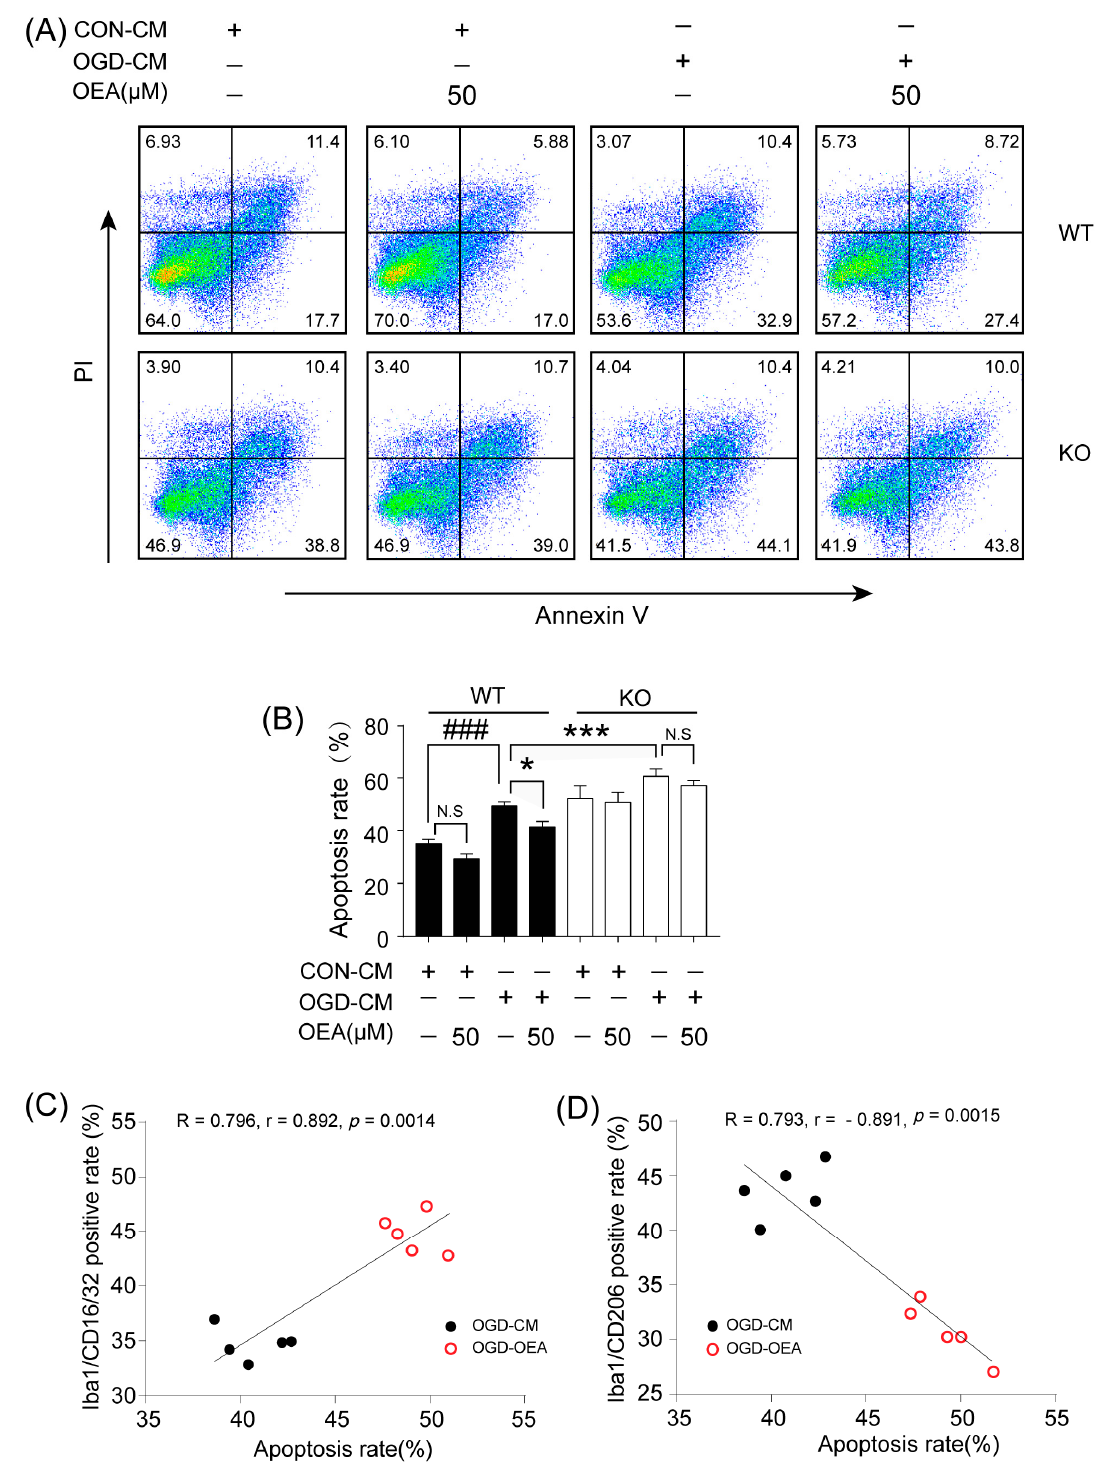
Figure 8. OEA treatment protects against OGD-induced neuronal apoptosis through PPAR α . ( A ) Neuronal apoptosis was assessed with flow cytometry using annexin V-FITC staining. ( B ) The relative apoptosis ratio was analyzed. ( C ) Pearson correlation between Iba1/CD16/CD32 posi- tive cells and neuronal apoptosis rate. ( D ) Pearson correlation between Iba1/CD206 positive cells and neuronal apoptosis rate. The data are presented as the mean ± SEM. n = 5. Each experiment was repeated 3 times. ### p < 0.001 vs. CON-CM group. * p < 0.05, *** p < 0.001 vs. OGD-CM group; N.S = No